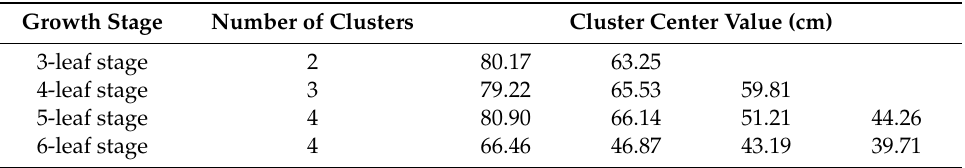
Table 1. Cluster center and test